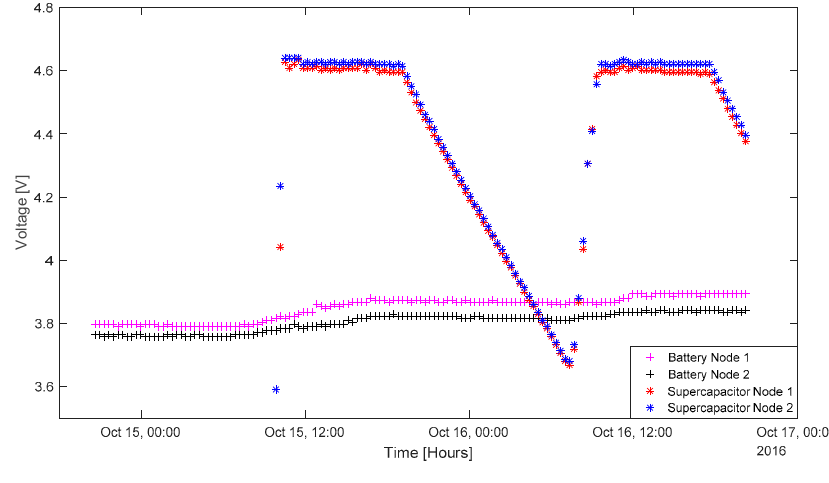
Figure 6. Energy storage unit voltage monitoring.